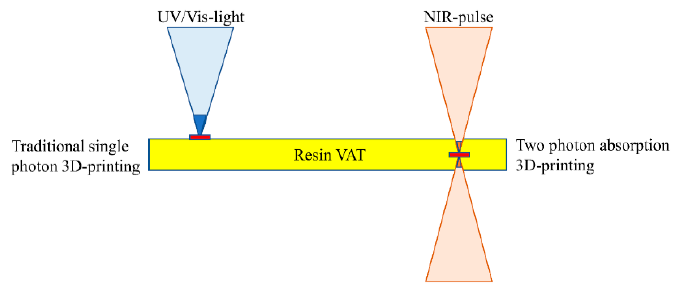
Figure 10. UV light is absorbed at the surface of a photosensitive resin, and can only be used for fabrication of planar structures (one-photon absorption). NIR light is focused into the volume of the photocurable resin and is used for 3D structuring (TPP). Reproduced with permission from [123]. Copyright © 2022 Elsevier.